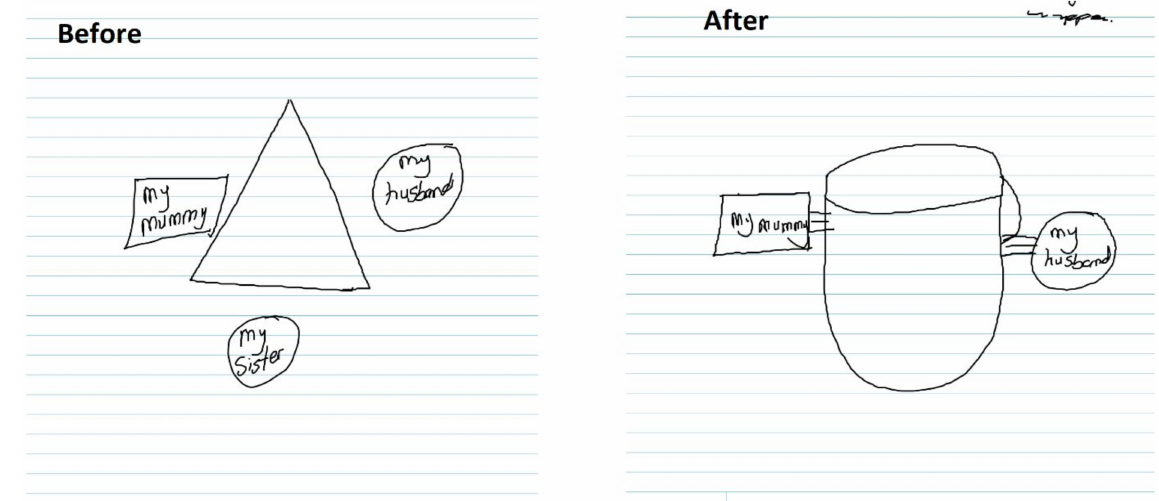
Figure 3. Ti aja ba ni eni lehin, a pa obo [with the support of others, a person can survive any challenges]